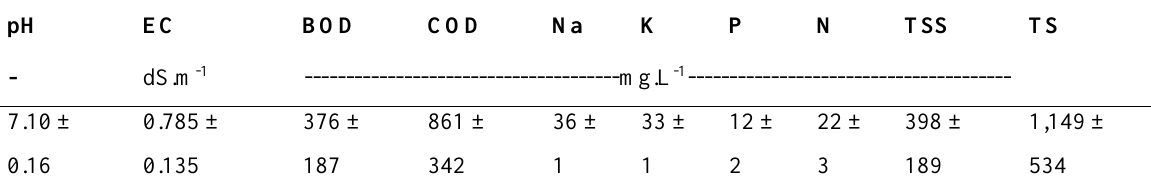
Table 5 Physical and chemical characterization of the WWTP-UFLA sewage during the fertigation